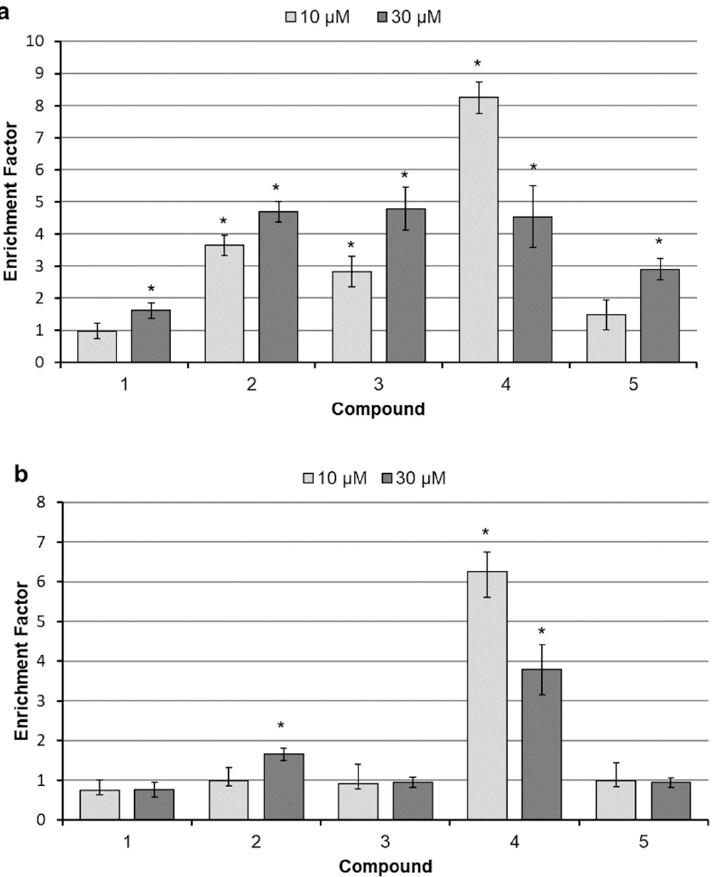
Figure 4. Determination of DNA fragmentation in SK-BR-3 ( a ) and MCF-7 ( b ) cells; cells were incubated with betulin and its derivatives for 24 h; cytosolic DNA/histone complexes were measured by ELISA; results are expressed as fold change over control; each bar represents the mean ± SD; * p < 0.05 compared with control.